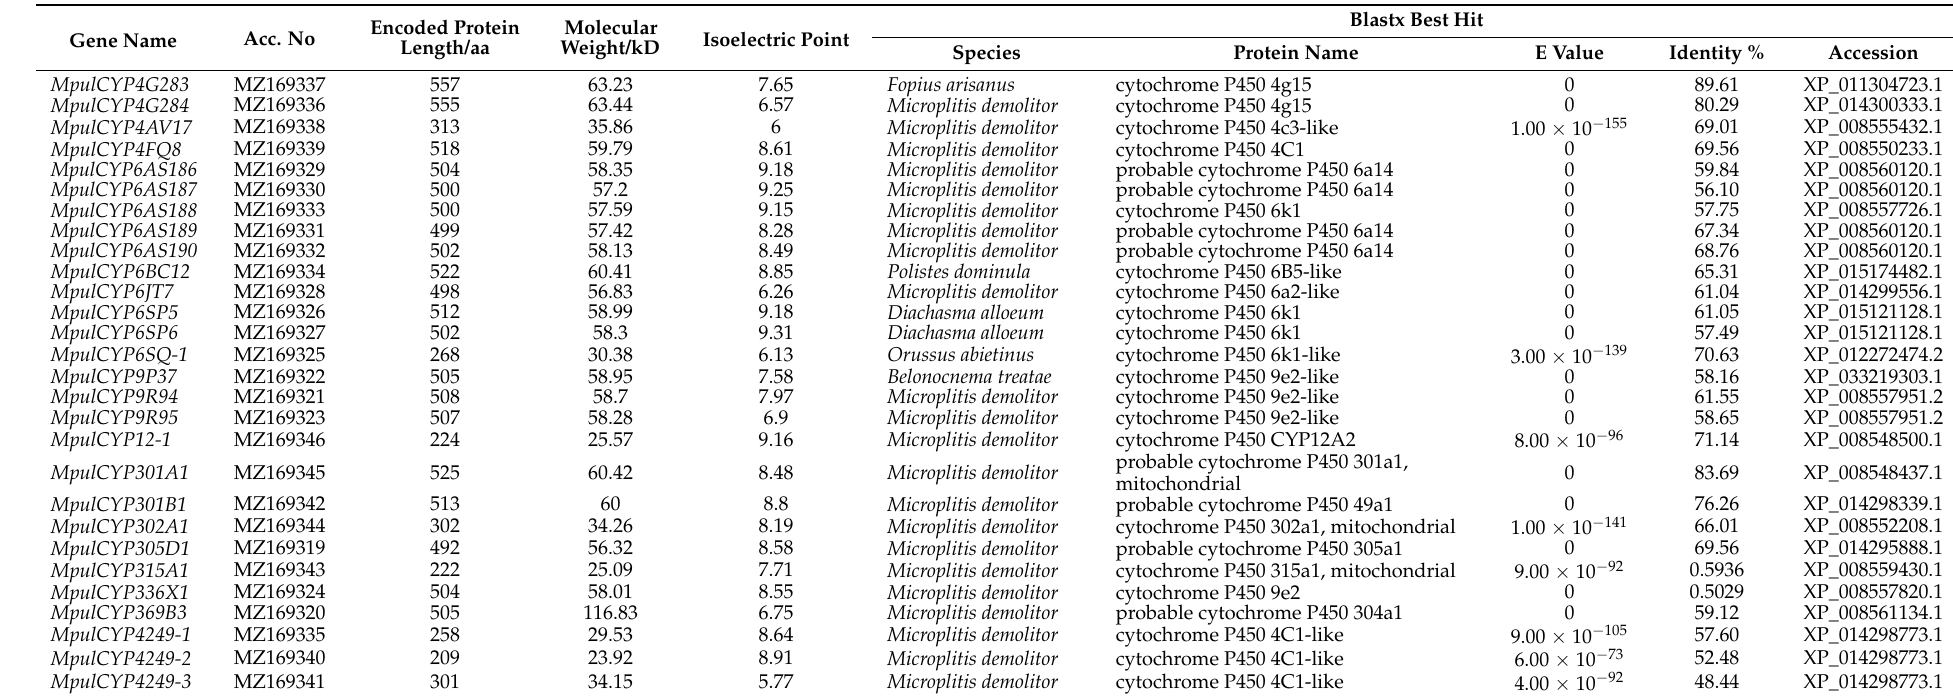
Table 1. Sequence information of identified MpulCYP